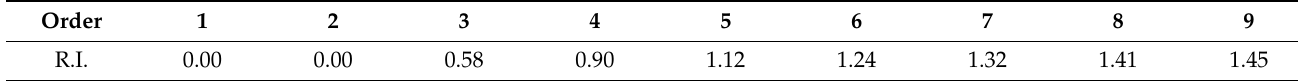
Table 6. Average random consistency index